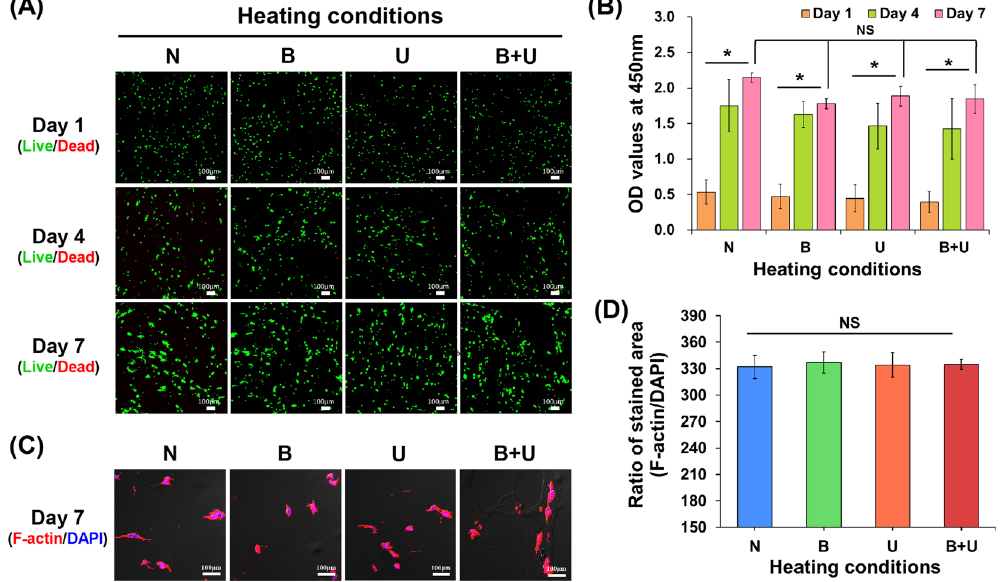
Figure 7. Analysis of cellular activities. ( A ) Live/dead assay results of NIH3T3 cells under different heating conditions. (scale bar: 100 μ m) ( B ) Cell proliferation tests via CCK-8 assay. ( * p < 0.001, NS = no significant difference) ( C ) F-actin (red)/DAPI (blue) images indicated cell spreading on day 7. (scale bar: 100 μ m) ( D ) Analysis of the ratio of the stained area under different heating